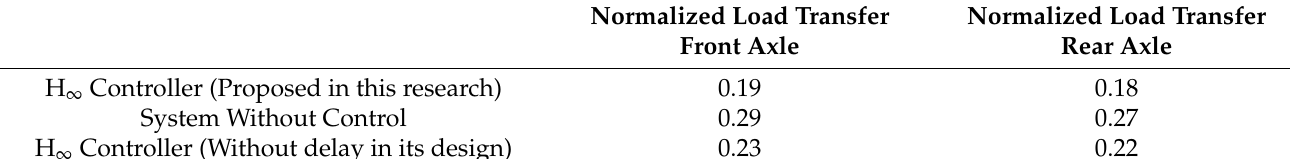
Table 5. Normalized Load Transfer for test 2.